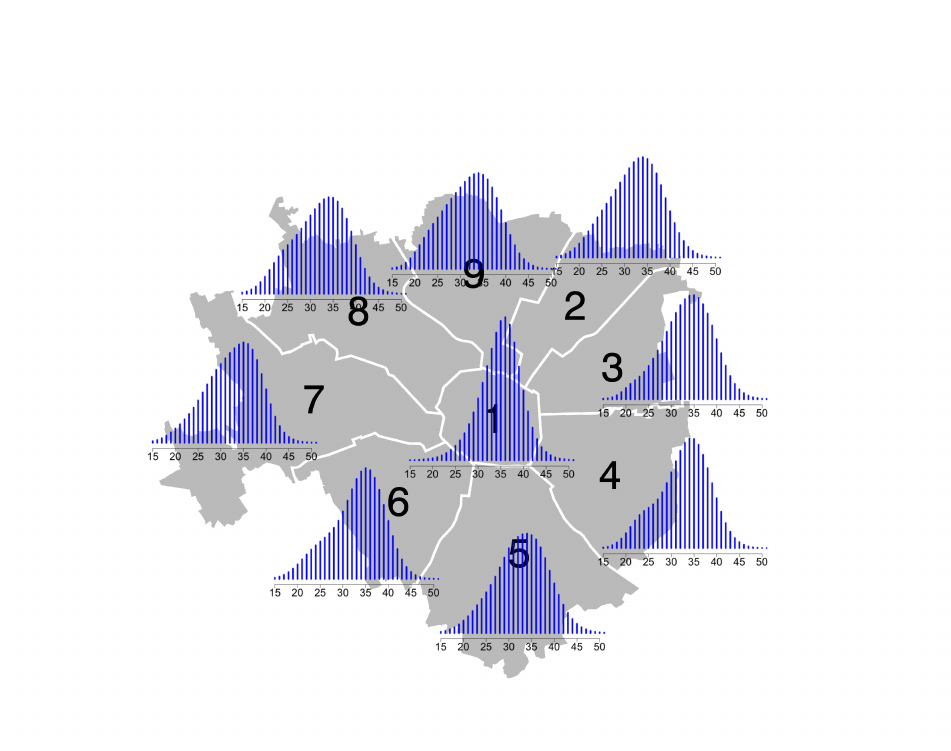
Figure 1 – Posterior mean probability mass function for the age of the mother at child- birth in the nine Milan